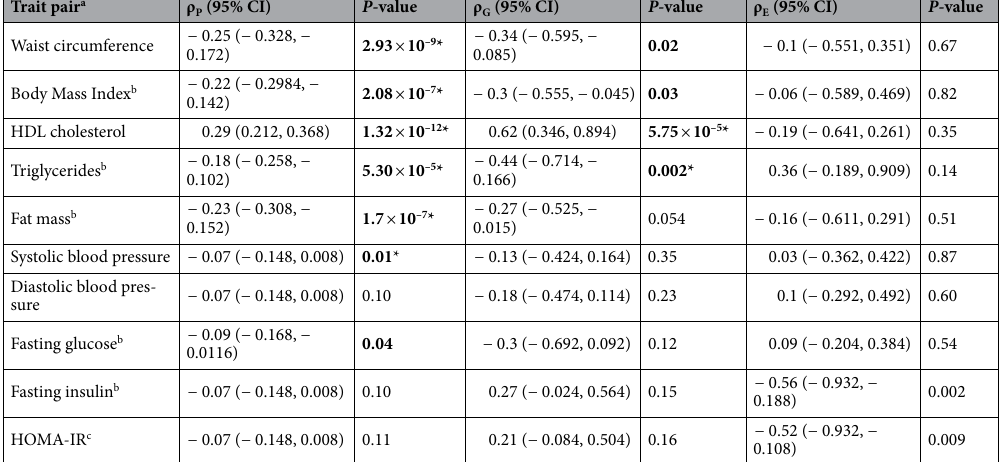
Table 3. Phenotypic (ρ P ), genetic (ρ G ) and environmental (ρ E ) correlations between β-cryptoxanthin and the cardiometabolic risk traits. HDL cholesterol, high-density lipoprotein cholesterol, HOMA-IR the homeostasis model of assessment-insulin resistance. Asterisks indicate the p-values that remain significant after applying FDR correction. Bold values denote statistical significance at P -value ≤ 0.05. a All traits were adjusted for the covariate effects of age and sex terms. b Data were log-transformed. c Trait was transformed using inverse normal